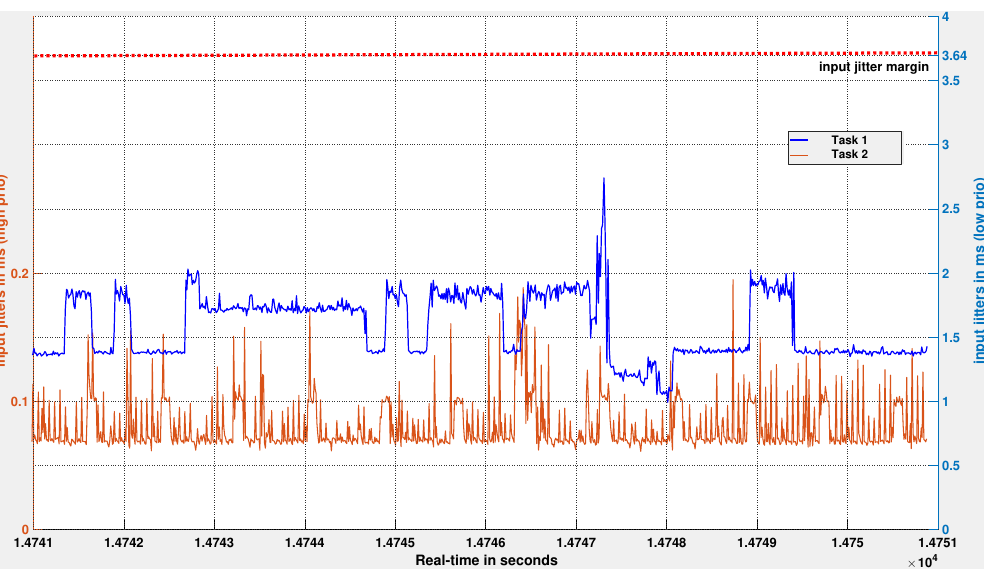
Figure 11. Global view of input jitter measurements of Task 1 and Task 2. The input jitter J h of Task 1 (blue curve, right y-axis) varies over time below 2 ms, except in rare cases where it reaches 2.7 ms. The input jitter of Task 2 (red curve, left y-axis) is bounded by 0.2 ms. The design assumption of input jitters for Task 1 is less than 3.64 ms is met by the implementation.